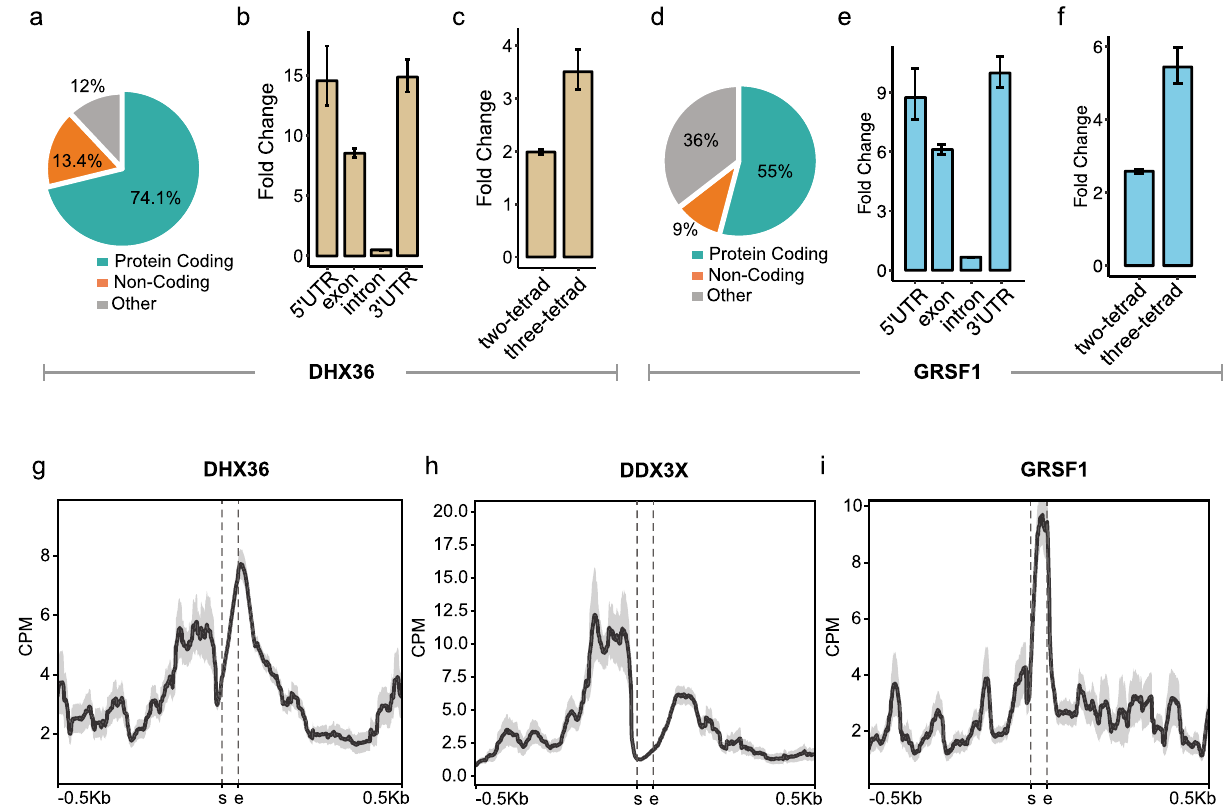
Figure 1. RNA binding proteins interact with G4s in mRNA. ( a,d ) Incidence of iCLAE peaks within protein- coding, non-coding or unannotated regions (other) of the genome. ( b,e ) Enrichment of iCLAE peaks at annotated RNA features. ( c,f ) Enrichment of iCLAE peaks at predicted G4 motifs. Enrichment calculated following random shuffling of peaks in the transcriptome (FDR = 1 × 10 −4 ). Error bars represent 95% confidence interval. ( g–i ) Distribution of DHX36, DDX3X and GRSF1 iCLAE reads relative to G4 motifs. Graphs denote pileups of iCLAE reads from multiple sites in CPM. DDX3X iCLAE data has been previously published 11